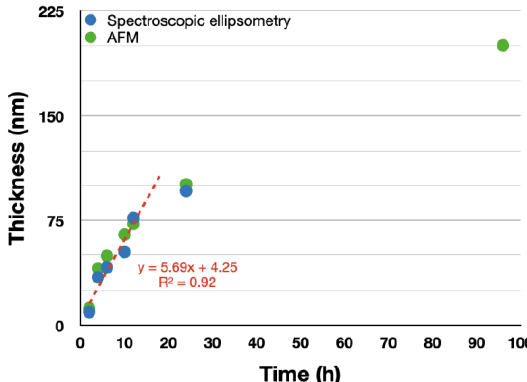
Figure 2. Relationship between the thickness of poly( St-D - alt - Ma-A ) brushes and the time of RAFT polymerization. polymerization. Table 4. Influence of grafting density on the thickness and roughness of donor–acceptor brushes obtained via RAFT